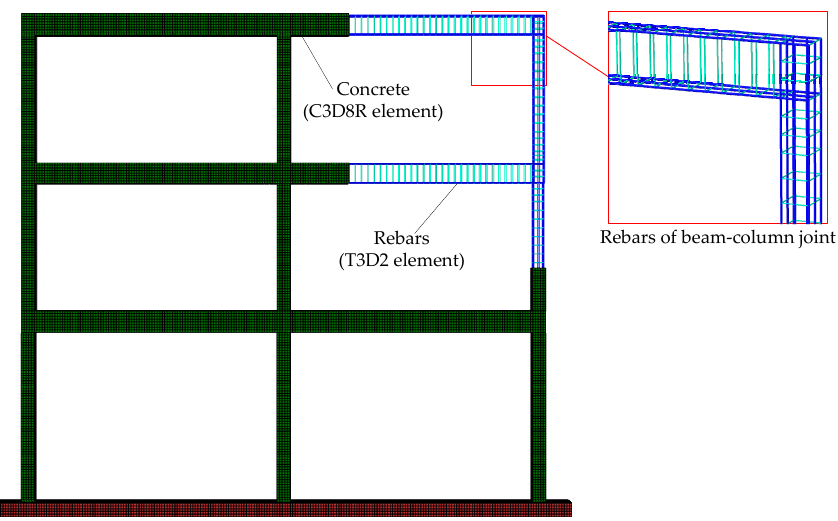
Figure 3. The planar three ‐ dimensional (3D) numerical model of intact RC